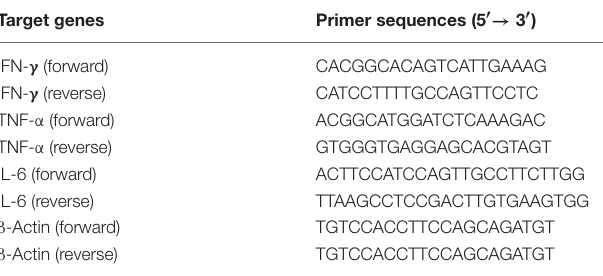
TABLE 1 | Primer sequences of target